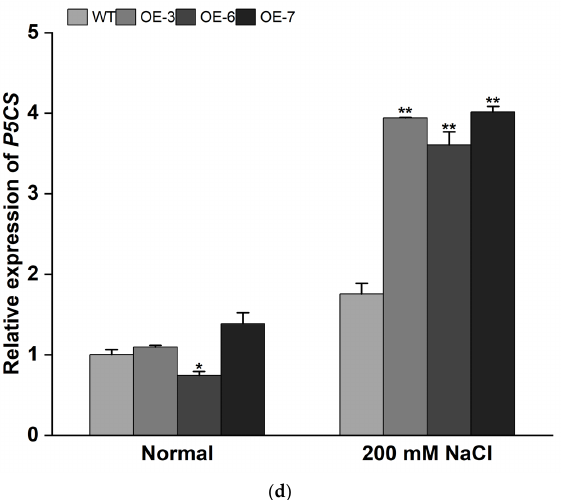
Figure 7. Relative expression of abiotic stress-responsive genes in the transgenic and WT tobacco plants. The abiotic stress-responsive genes of ( a ) SOD , ( b ) POD , ( c ) APX , and the proline synthesis- related gene, ( d ) P5CS . NtActin was used as the internal reference gene. Data are presented at the means of three biological replicates ± SD ( n = 3 ). * and ** indicate significant differences at p < 0.05 and p < 0.01, respectively.